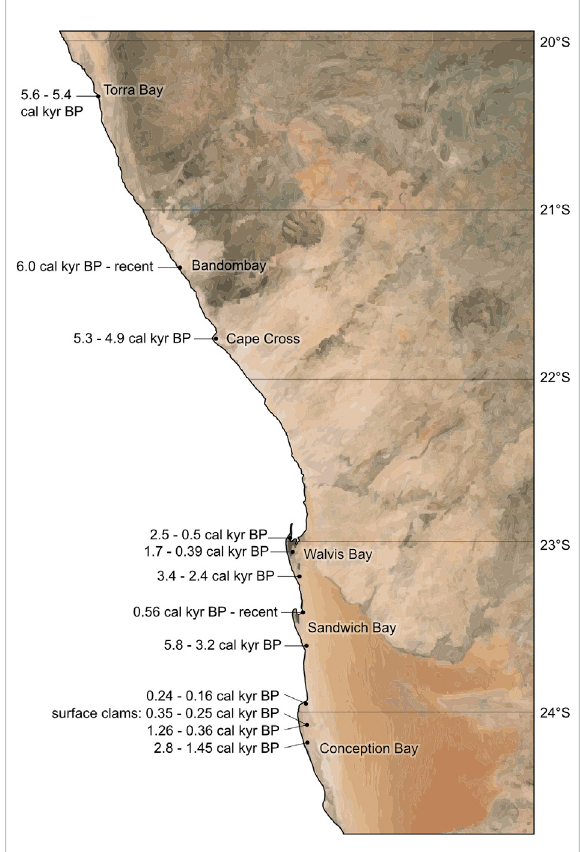
FIGURE 5 Spatial distribution of the calibrated 14 C AMS age datings.